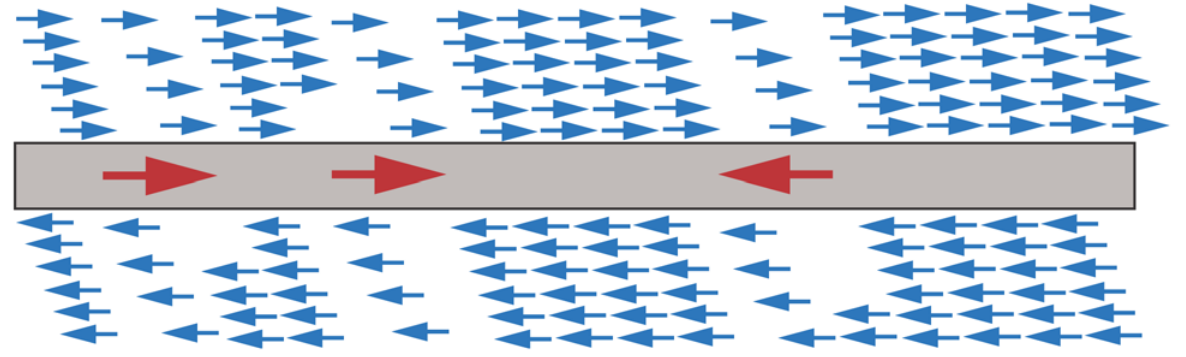
Figure 1. Tiling strategy. The genome was divided into coding and non-coding regions, and the two region types were probed with different densities. The grey bar represent the genome, red arrows represent genes and the blue arrows represent probes. The numbers of probes are not realistic here (see Table S1 for density details).